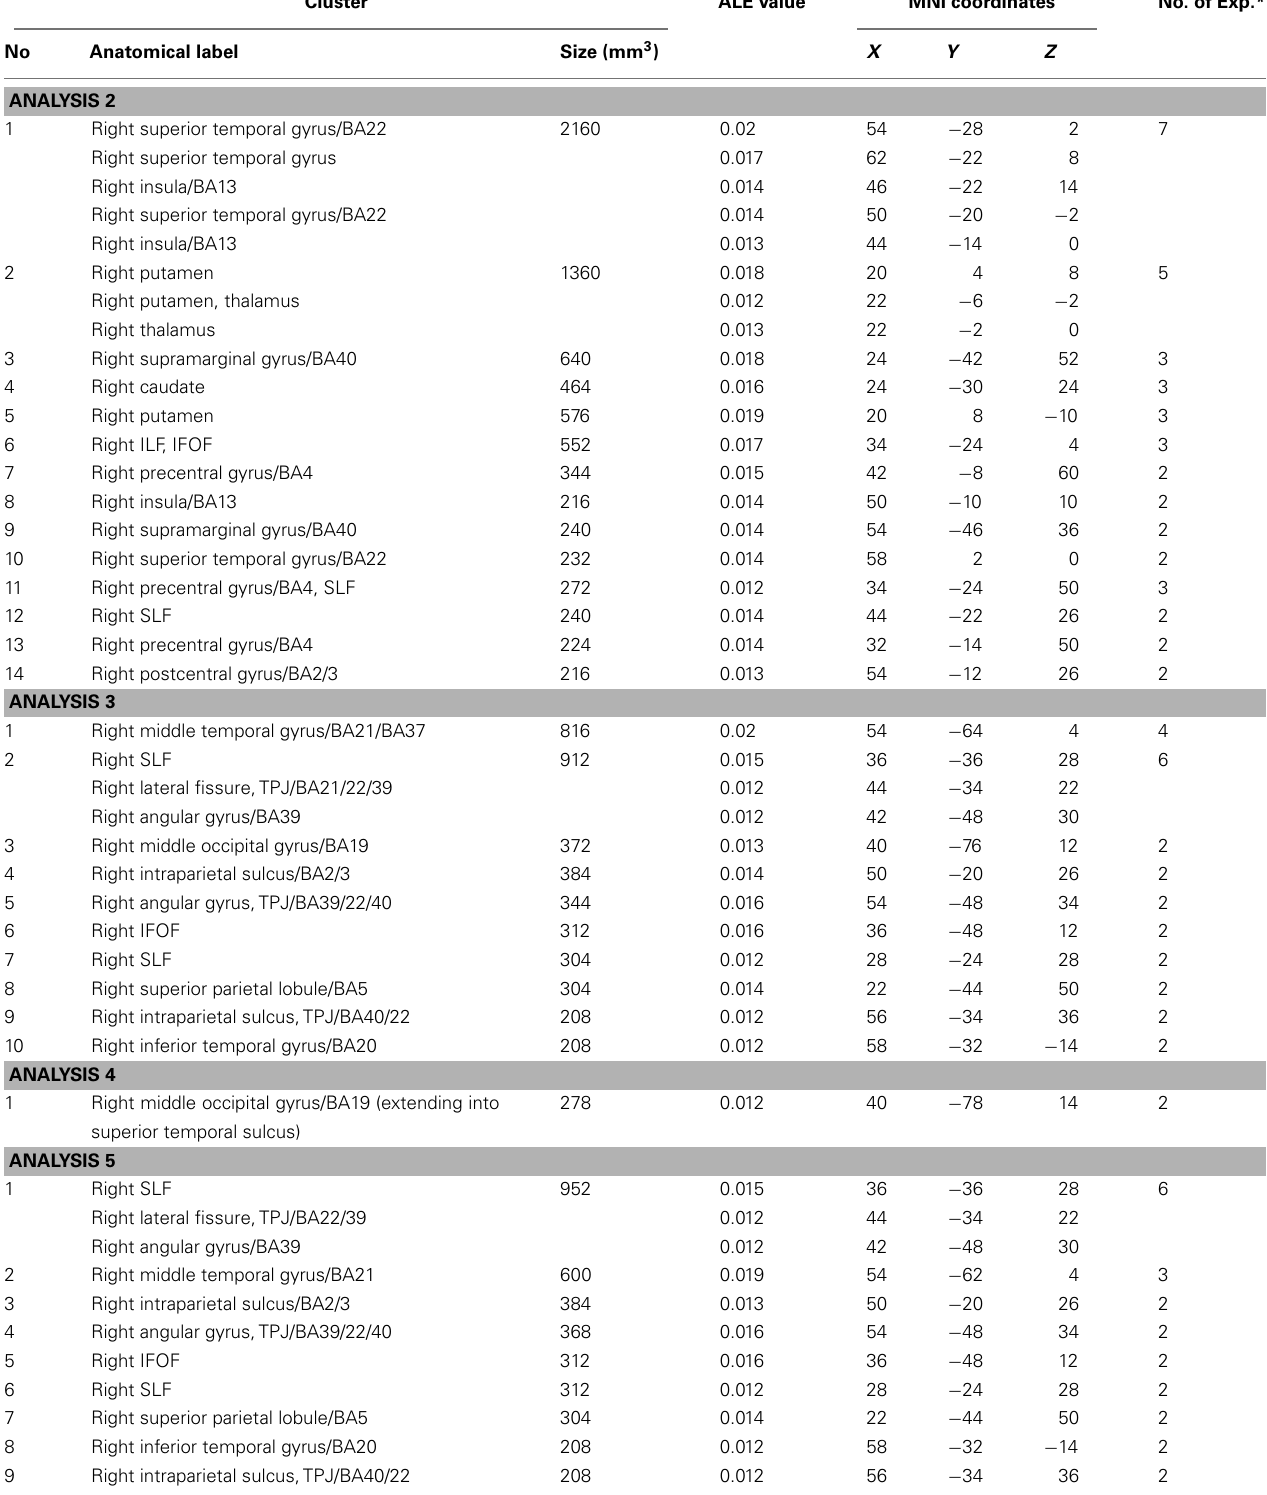
Table 3 | SignificantALE clusters and corresponding MNI coordinates identified inAnalyses 2, 3, 4, and